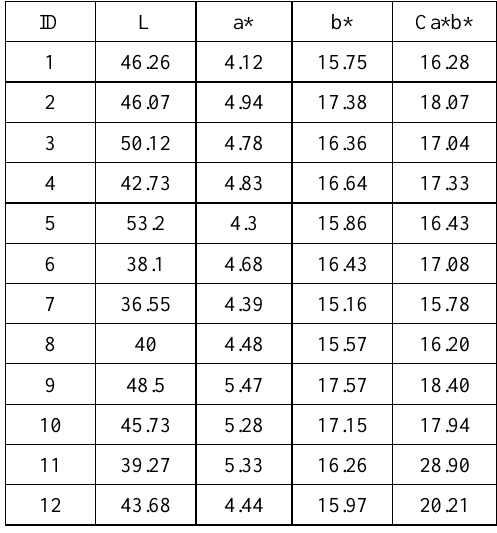
Table 1. Chromaticity index of experimental